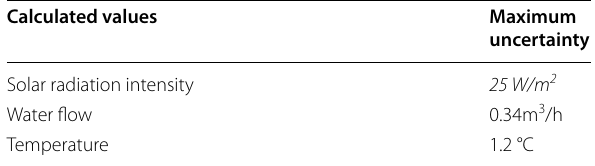
Table 2 The uncertainty of calculated